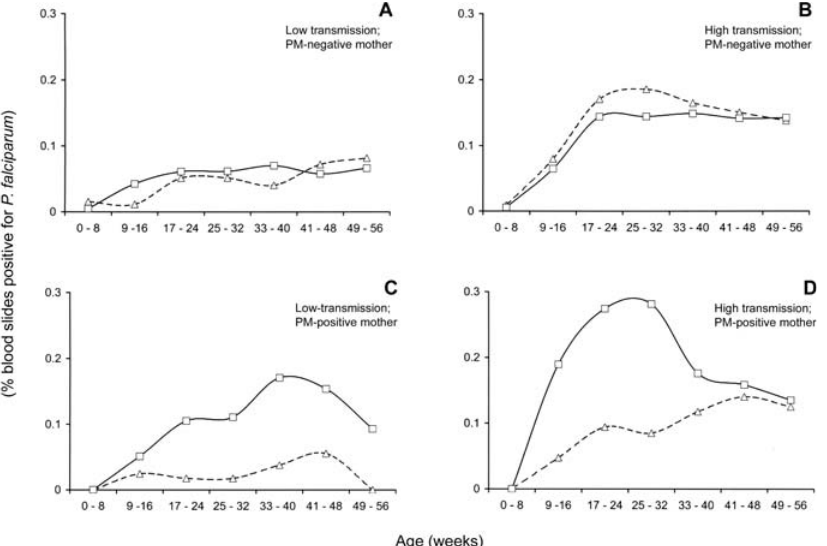
Figure 3. Age-Specific Parasite